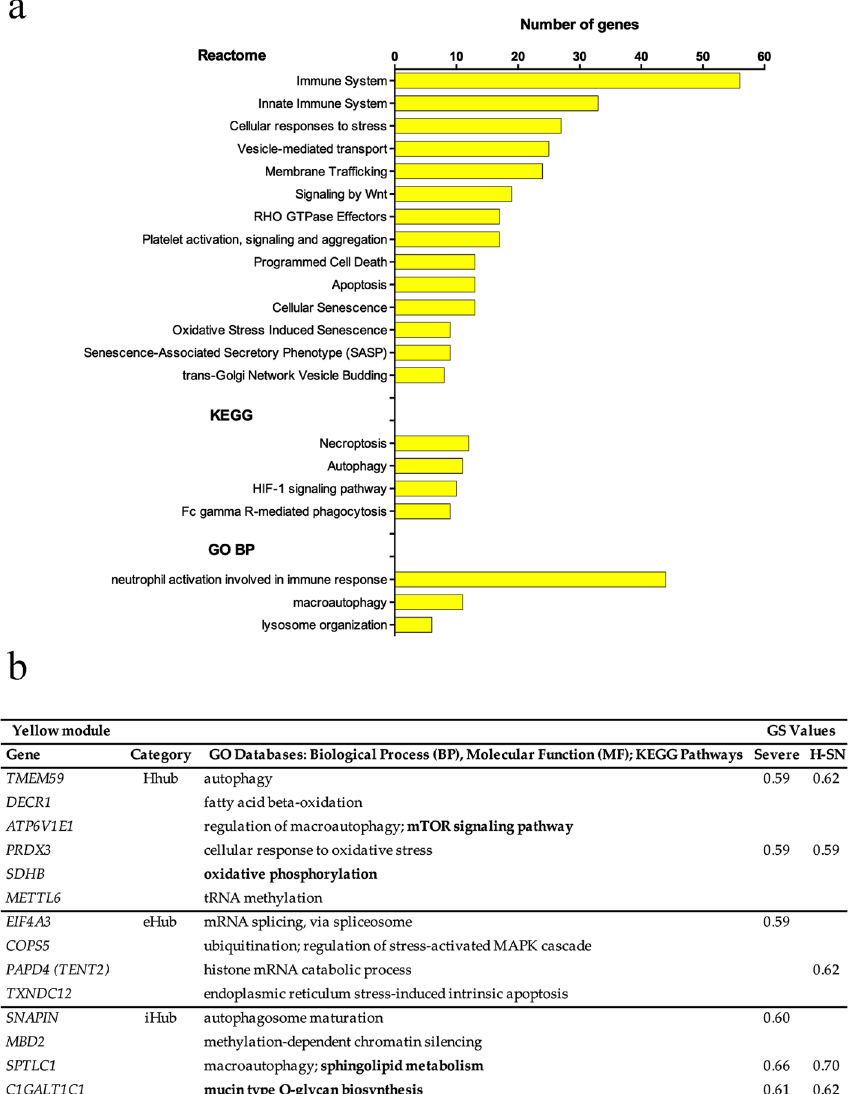
Figure 2. Enrichment analysis and high hierarchy genes (HH genes) for the yellow module. ( a ) Histogram of enriched Reactome, KEGG pathways, and GO BP terms. The terms with adjusted p < 0.05 were considered significant. ( b ) HH genes (Hhubs, iHubs, and eHubs) of this module, which is significantly and positively correlated with Severe group, subgroup B, H-SN, and L-Lymphs traits. Each HH gene is identified by its hierarchical categorization, GO biological process or molecular function, and KEGG Pathways-related terms (in bold letters). Only positive (i.e., hyper-expressed) or negative (i.e, hypo-expressed) significant GS values for the specific trait ( p < 0.01) are shown. H‑SN high percentage of segmented neutrophils in the hemogram, GS gene